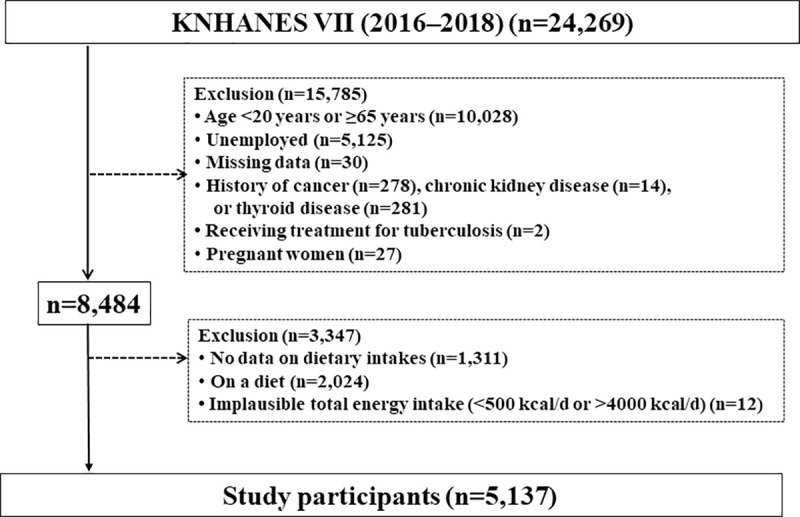
Flowchart for the inclusion of study participants (KNHANES VII 2016–2018).